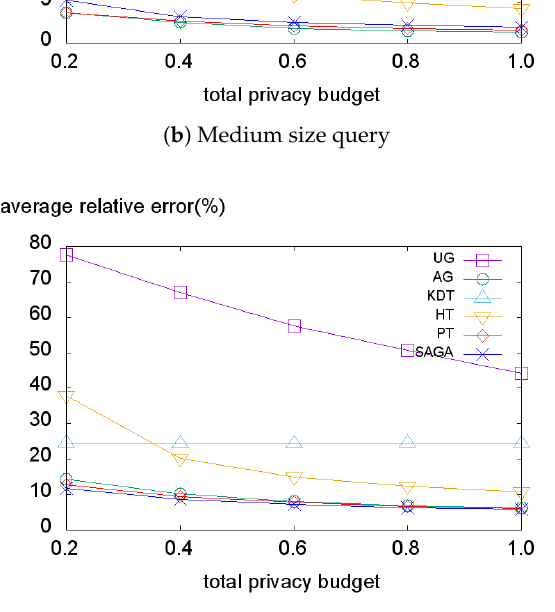
Figure 13. Average relative error on the TIGER